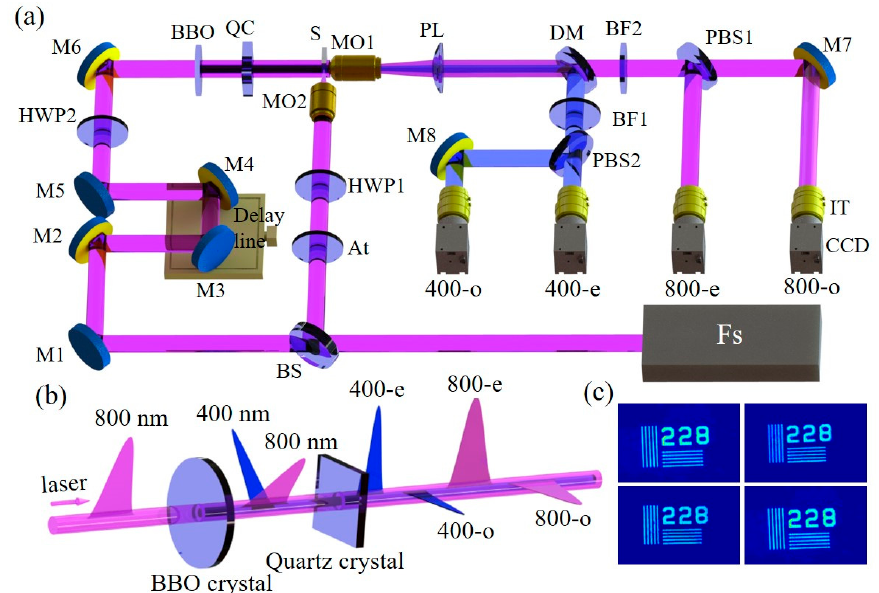
Figure 1. ( a ) Experimental setup for the single-shot ultrafast multi-frame imaging. The red beam represents 800 nm while the blue is 400 nm ( b ) Probe pulse train propagation. ( c ) Spatial resolution test under four sub-pulses, 228 lp/mm, the length of each line is 52.6 µm, and the width is 2.2 µm.